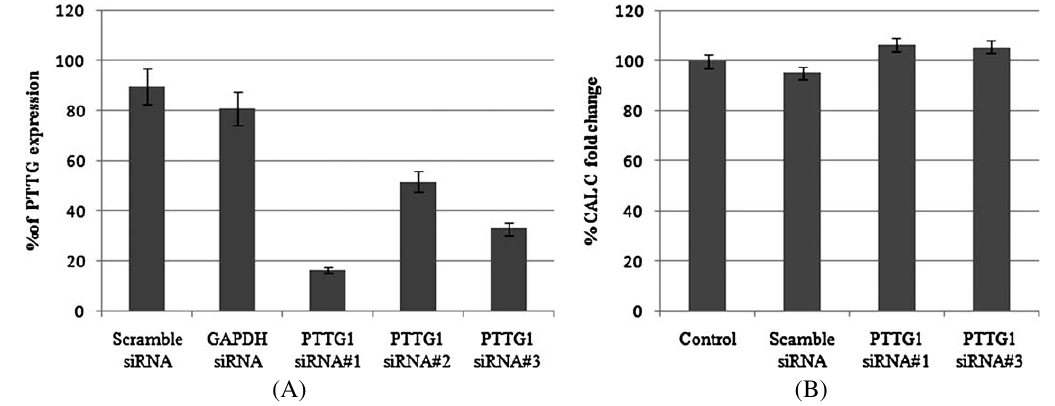
Fig. 3. RQ-PCR evaluating the effect of gene silencing on PTTG1 and CALC mRNA expression in TT cells. (A) TT cells were transfected with scramble siRNA, GAPDH siRNA, or with PTTG1 siRNA #1, #2 and #3. After 72 h, cells were harvested and used for RNA isolation. One µg RNA was reverse-transcribed and RQ-PCR performed to evaluate PTTG1 mRNA expression. Data are shown as percentage of PTTG1 expression in transfected TT cells as compared to control untransfected TT cells (100%), and represent the mean value ± SE of at least three independent experiments. ∗∗ p < 0 . 01 vs. control untransfected TT cells. (B) TT cells were transfected with scramble siRNA, GAPDH siRNA, or with PTTG1 siRNA #1 and #3. After 72 h, cells were harvested and submitted to RNA isolation. One µg of RNA was reverse-transcribed and RQ-PCR performed to evaluate CALC mRNA expression. Data are shown as percentage vs. CALC expression in TT cells transfected with GAPDH siRNA, PTTG1 siRNA #1–3 as compared to untransfected TT cells and represent the mean value ± SE of at least three independent experiments.